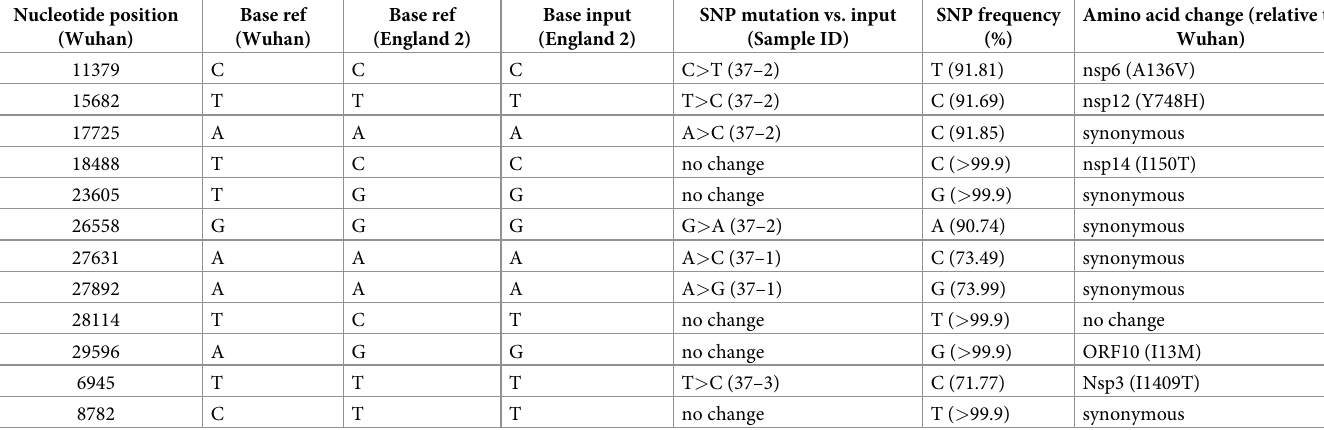
Table 1. SARS-CoV-2 sequence summary. SARS-CoV-2 RNA isolated from apical washes collected from donor 1 infected tissues incubated at 37 or 40˚C at 72 h were subjected to amplicon sequencing. Reference (ref) sequences (Wuhan, MN908947.3; England 2, EPI_ISL_407073) were used for consensus alignment and SNP identifica- tion. Unique SNPs (not detected in input and > 5% base count frequency) and frequency (%base counts) shown. Full SNP analysis presented in S2 Data. Nucleotide position